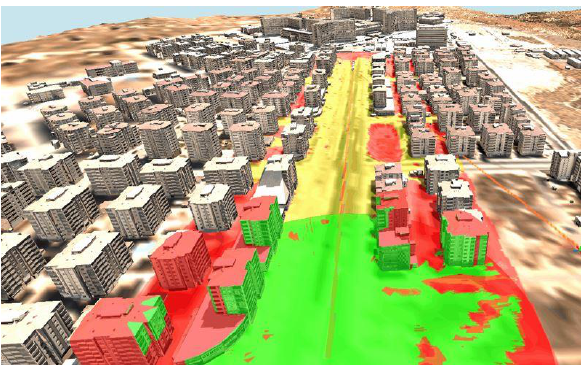
Figure 10. Example of Viewshed-2 (CityGenius)